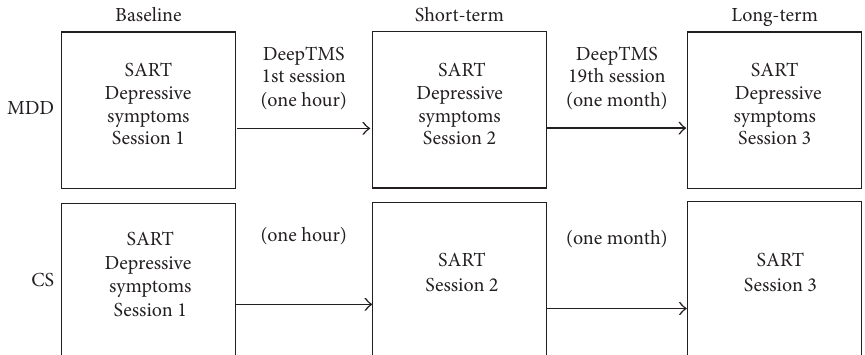
Figure1:Timelineofthestudyprocedure.IntheMajorDepressiveDisorder(MDD)group,cognitiveperformanceontheSustainedAttention to Response Task (SART) was assessed at three time-points. Session 1 (baseline), Session 2 after a single application of deepTMS (short-term), and Session 3 immediately prior to the 20th application of deepTMS (long-term). To control for the presence of a practice effect, cognitive performance was also evaluated at the same three time-points in the control subjects (CS); however, CS were not administered the deepTMS